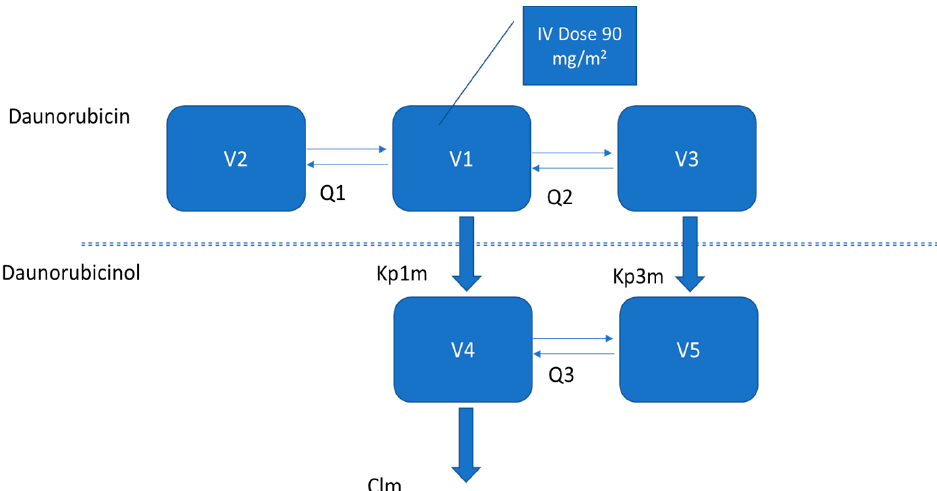
Figure 2. Structural PK model of daunorubicin and its metabolite daunorubicinol. V1: central parent compartment; V2: 1st peripheral parent compartment; V3: 2nd peripheral parent compartment; Q1: intercompartmental 1 and 2 clearance; Q2: intercompartmental 1 and 3 clearance; V4: central metabolite compartment; V5: peripheral metabolite compartment; Q3: intercompartmental 4 and 5 clearance; kp1m: transformation rate from V1 to V4; kp3m: transformation rate from V3 to V5.